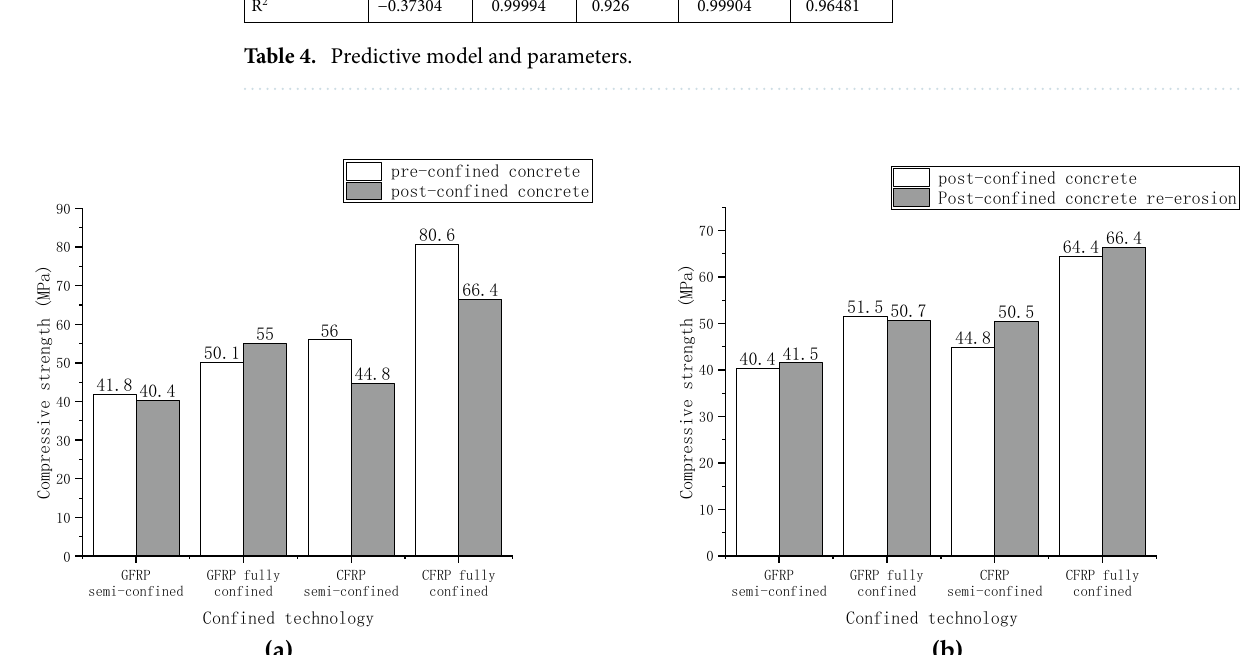
Figure 11. Influence of confined sequence on concrete: (a) strength comparison of pre-confined and post- confined concrete; (b) strength comparison of post-confined and re-coupling